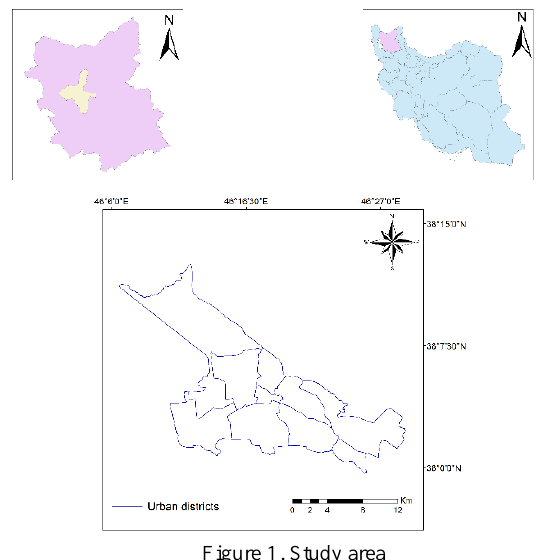
Figure 1. Study area